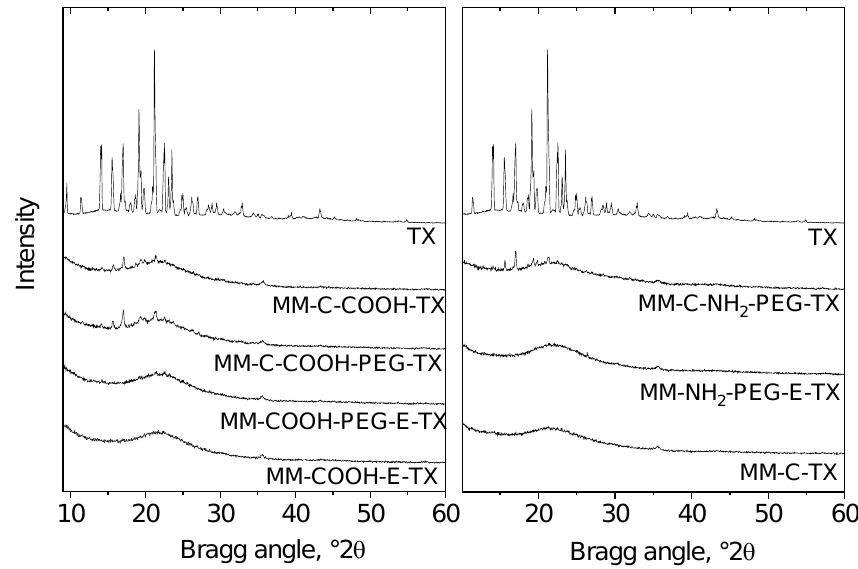
Figure 1. XRD patterns of the MCM-41 silica nanoparticles with magnetic iron oxides (MM) sample and its amino / PEG- or carboxylic / PEG-modified varieties loaded with tamoxifen. Reflections are widened due to the high dispersion of the iron oxide. The crystallite size calculated by the Sherrer equation applying the profile fitting method is about 20 nm. Reflections typical of tamoxifen (TX) with low intensity were detected on the TX-loaded formulations modified with COOH/NH 2 -groups and PEGylated after the template removal (MM-C-COOH-TX, MM-C-NH 2 -TX, MM-C-COOH-PEG-TX, MM-C-NH 2 -PEG-TX), indicating that a small part of